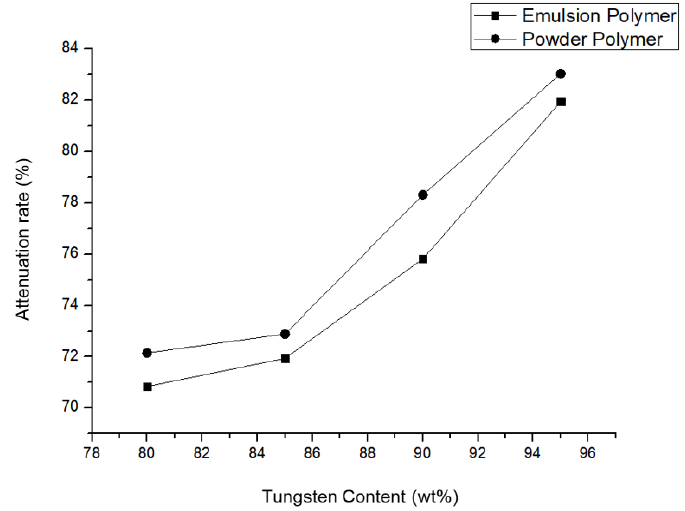
Figure 8. Variation in the shielding performance with respect to the tungsten content in the emulsion polymer- and powder polymer-based shielding films.